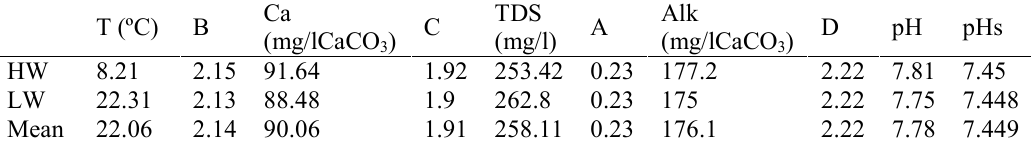
Table 2. Water Quality Analysis During the HW and LW Periods